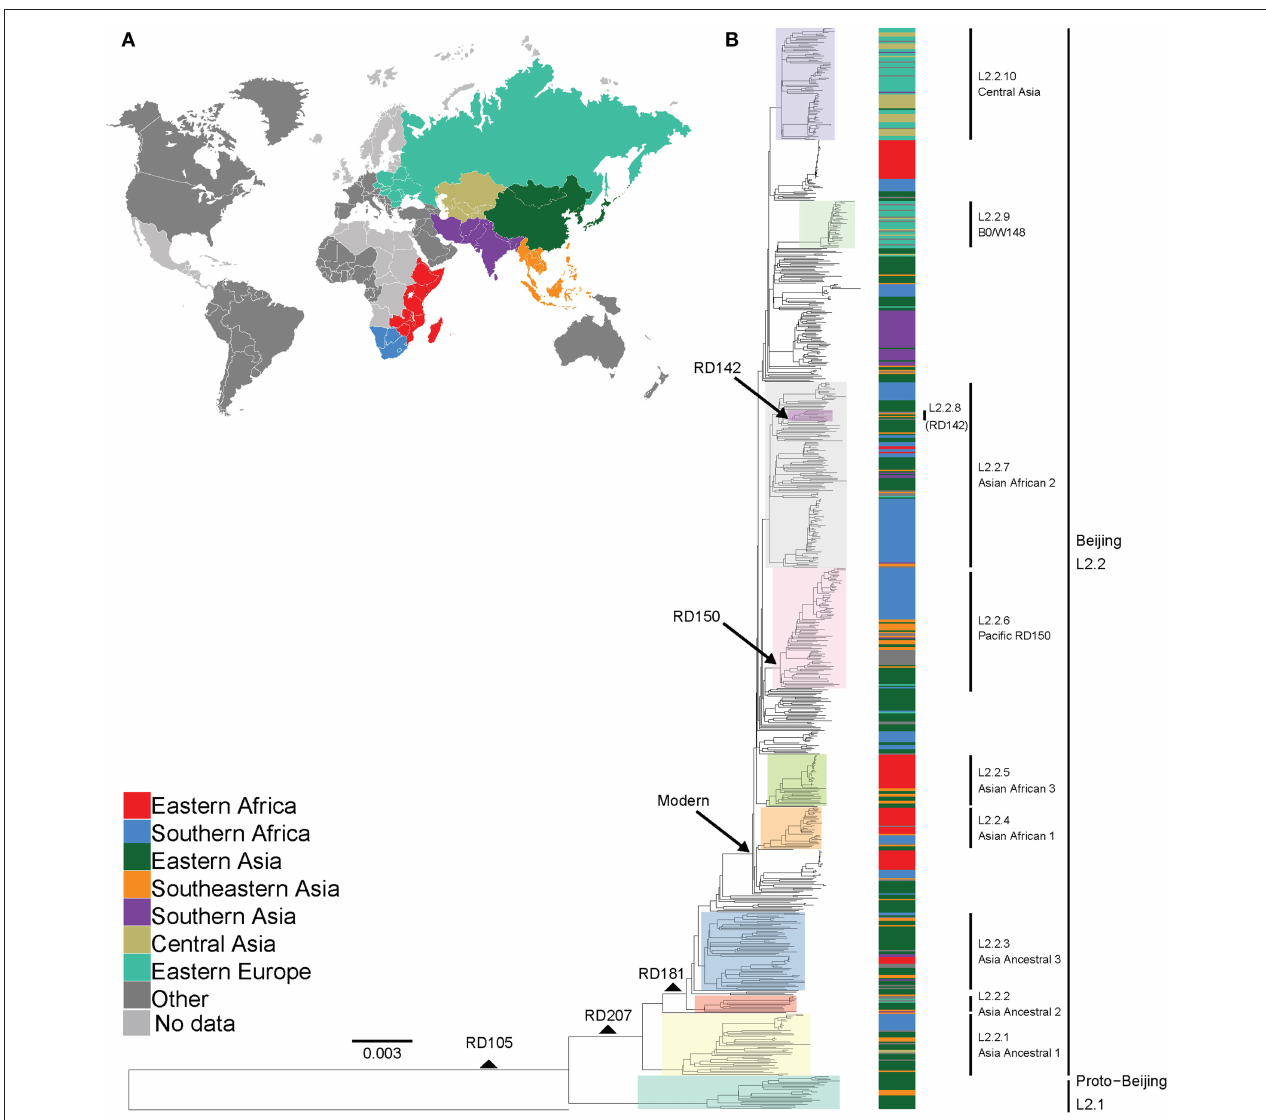
FIGURE 1 | Global phylogeny and geographical distribution of L2 strains. (A) Geographical origin (according to United Nations geoscheme) for the 781 L2 strains. The geographical origins with less than 20 strains are colored dark gray and those with missing data light gray. (B) Maximum likelihood phylogeny inferred from 32,269 variable single nucleotide positions of the 781 strains rooted with the reference strain H37Rv. Taxa are colored according to the geographical origin of the strains and the clades are highlighted according to previously defined sublineages. L2 defining markers i.e., deletions (RD) are also mapped onto the